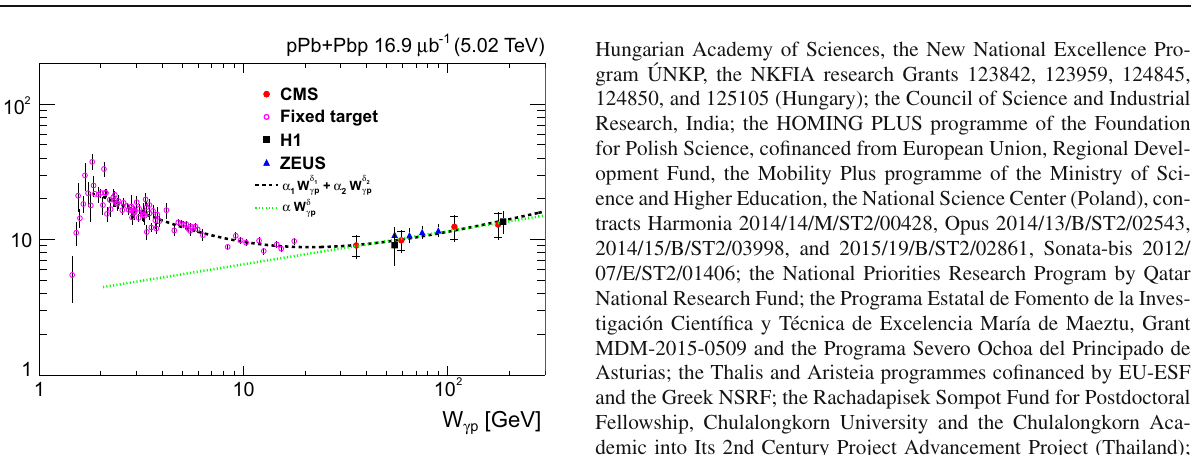
Fig. 8 Exclusive ρ ( 770 ) 0 photoproduction cross section as a func- tion of W γ p . The inner bars show the statistical uncertainty, while the outer bars represent the statistical and systematic uncertainties added in quadrature. Fixed-target [45–48] and HERA [17,18] data are also shown. The dashed lines indicate the results of the fits described in the